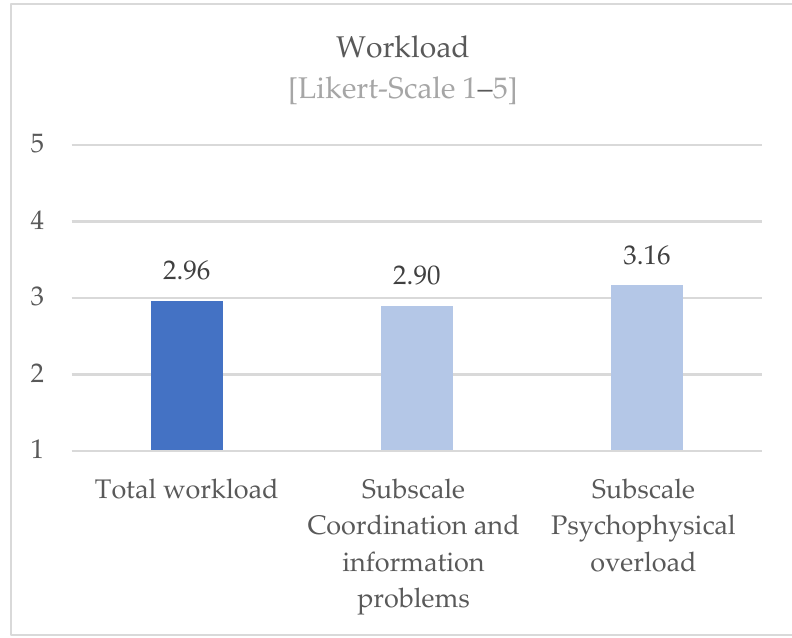
Figure 5. Results of the General Health Questionnaire among participants.